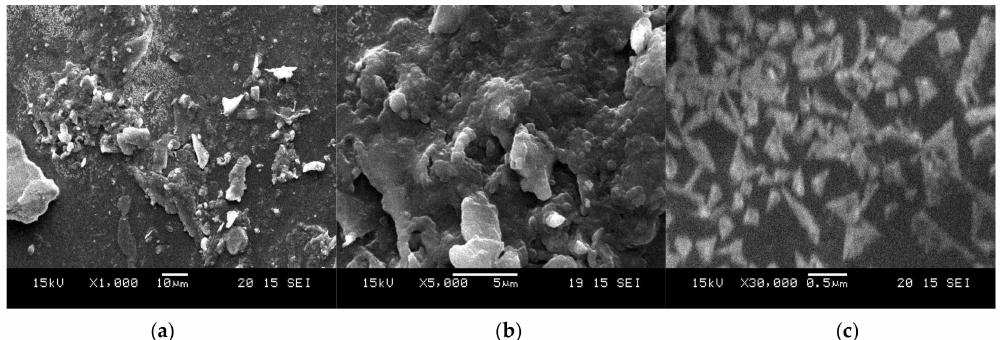
Figure 5. Tyr-Cu(II)-AEEA NPs of SEM images. SEM-EDAX images of Tyr-Cu(II)-AEEA NPs obtained ( a ) at 10 µ m, ( b ) at 5 µ m, and ( c ) at 0.5 µ m in a water